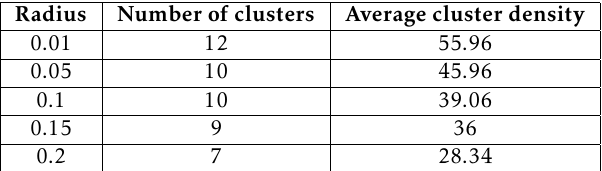
Table 3. Cluster numbers and their average density at varying radius